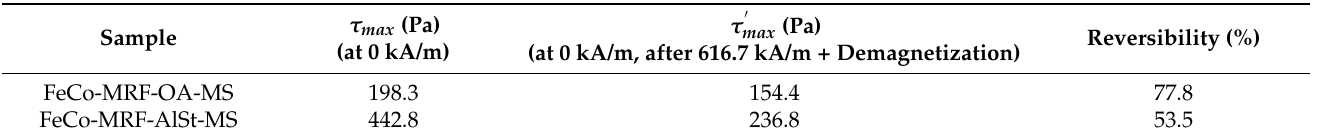
Table 3. Values of the stress measured at the maximum shear rate (600 s − 1 ) under different applied magnetic field conditions, for the two different surfactants